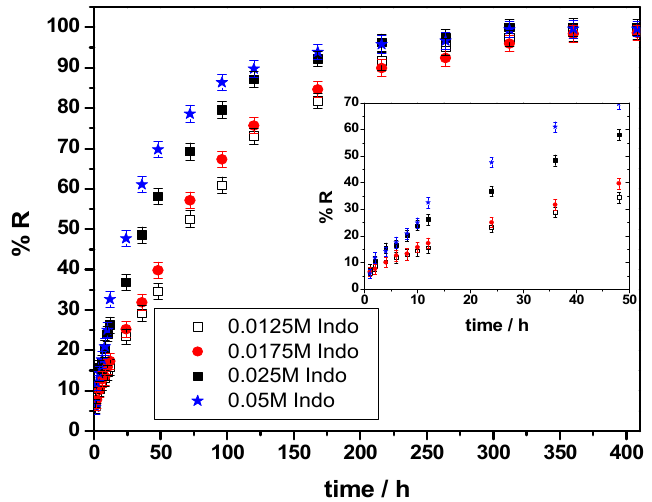
Figure 11. Indomethacin release profiles from the PPy-Indo coatings electrosynthesized on IB from ILM-ACN based electrolyte containing 0.5 M Py and various Indo concentrations. Inset: burst drug release.